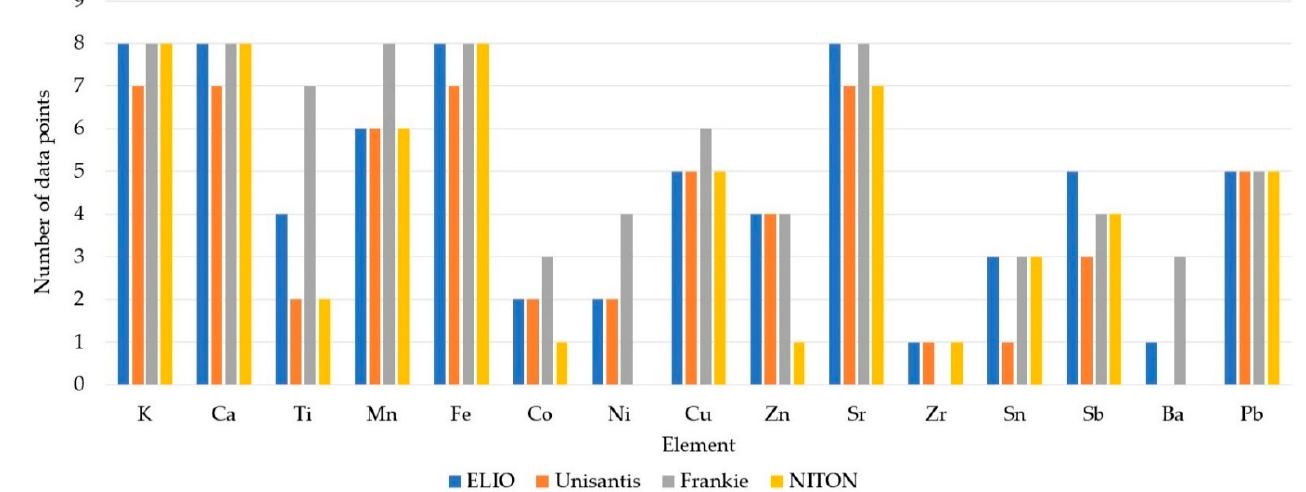
Figure 2. Number of data points considered in this study for each XRF unit with the division for each element of interest.